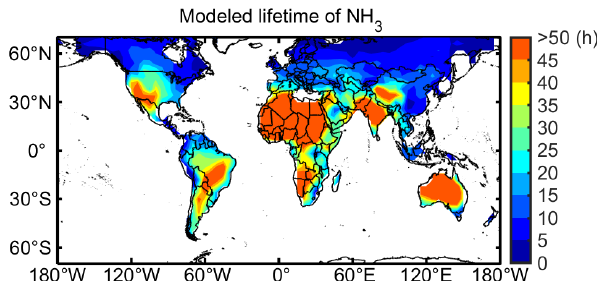
Figure 6. Spatial distribution of the NH 3 lifetime (h) diagnosed from GEOS-Chem (Eq. 2) within the 70 ◦ N–70 ◦ S band during